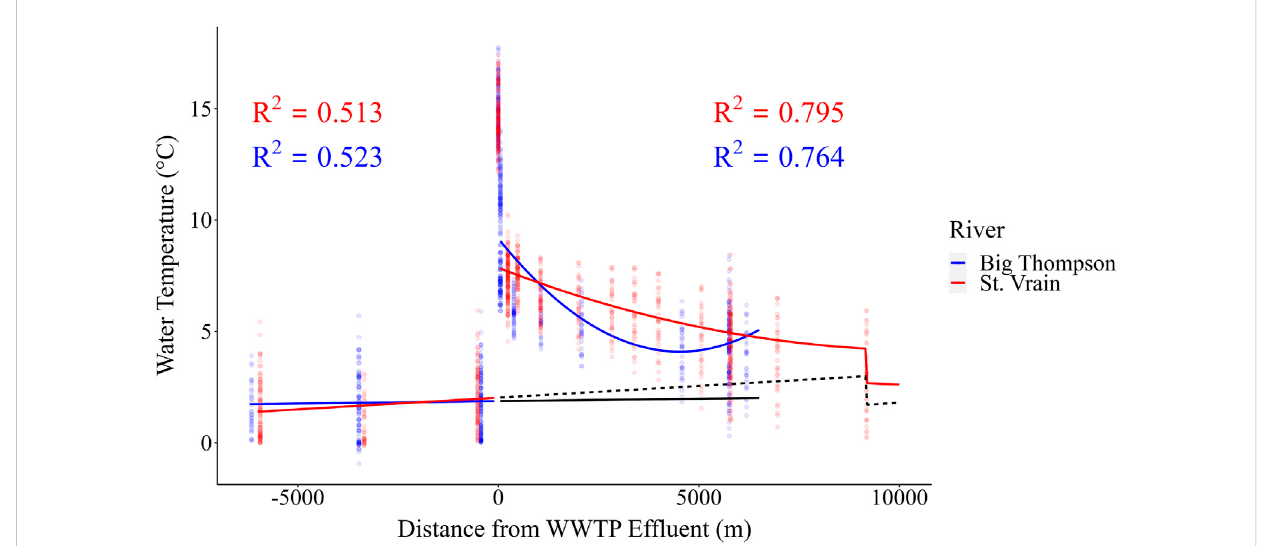
FIGURE 3 Daily average water temperatures at each monitoring site on the Big Thompson and St. Vrain for winters 2020 – 2021 and 2021 – 2022 in relation to distance from the WWTP ef fl uent input and predicted water temperatures from the upstream and downstream models (Table 1; Table 2). Measured ef fl uent temperatures are represented at point 0. Predictions were calculated using model coef fi cients along with average air temperature, discharge, andef fl uent temperature(14.5 ° C).The blacklines (solid forBig Thompsonand dashedfor St.Vrain) showpredicted dailyaveragewater temperature calculatedwithupstreammodelcoef fi cients, averagedailyairtemperatureandaveragedailydischarge forcomparisonofwatertemperatureestimatesif no ef fl uent input was present.